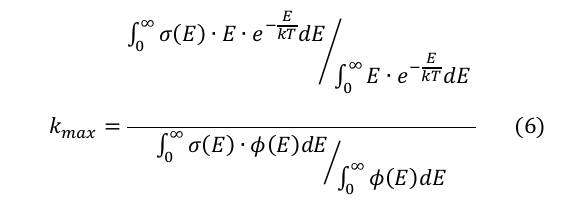
Table 1. Experimental data, obtained corrections and MACS.